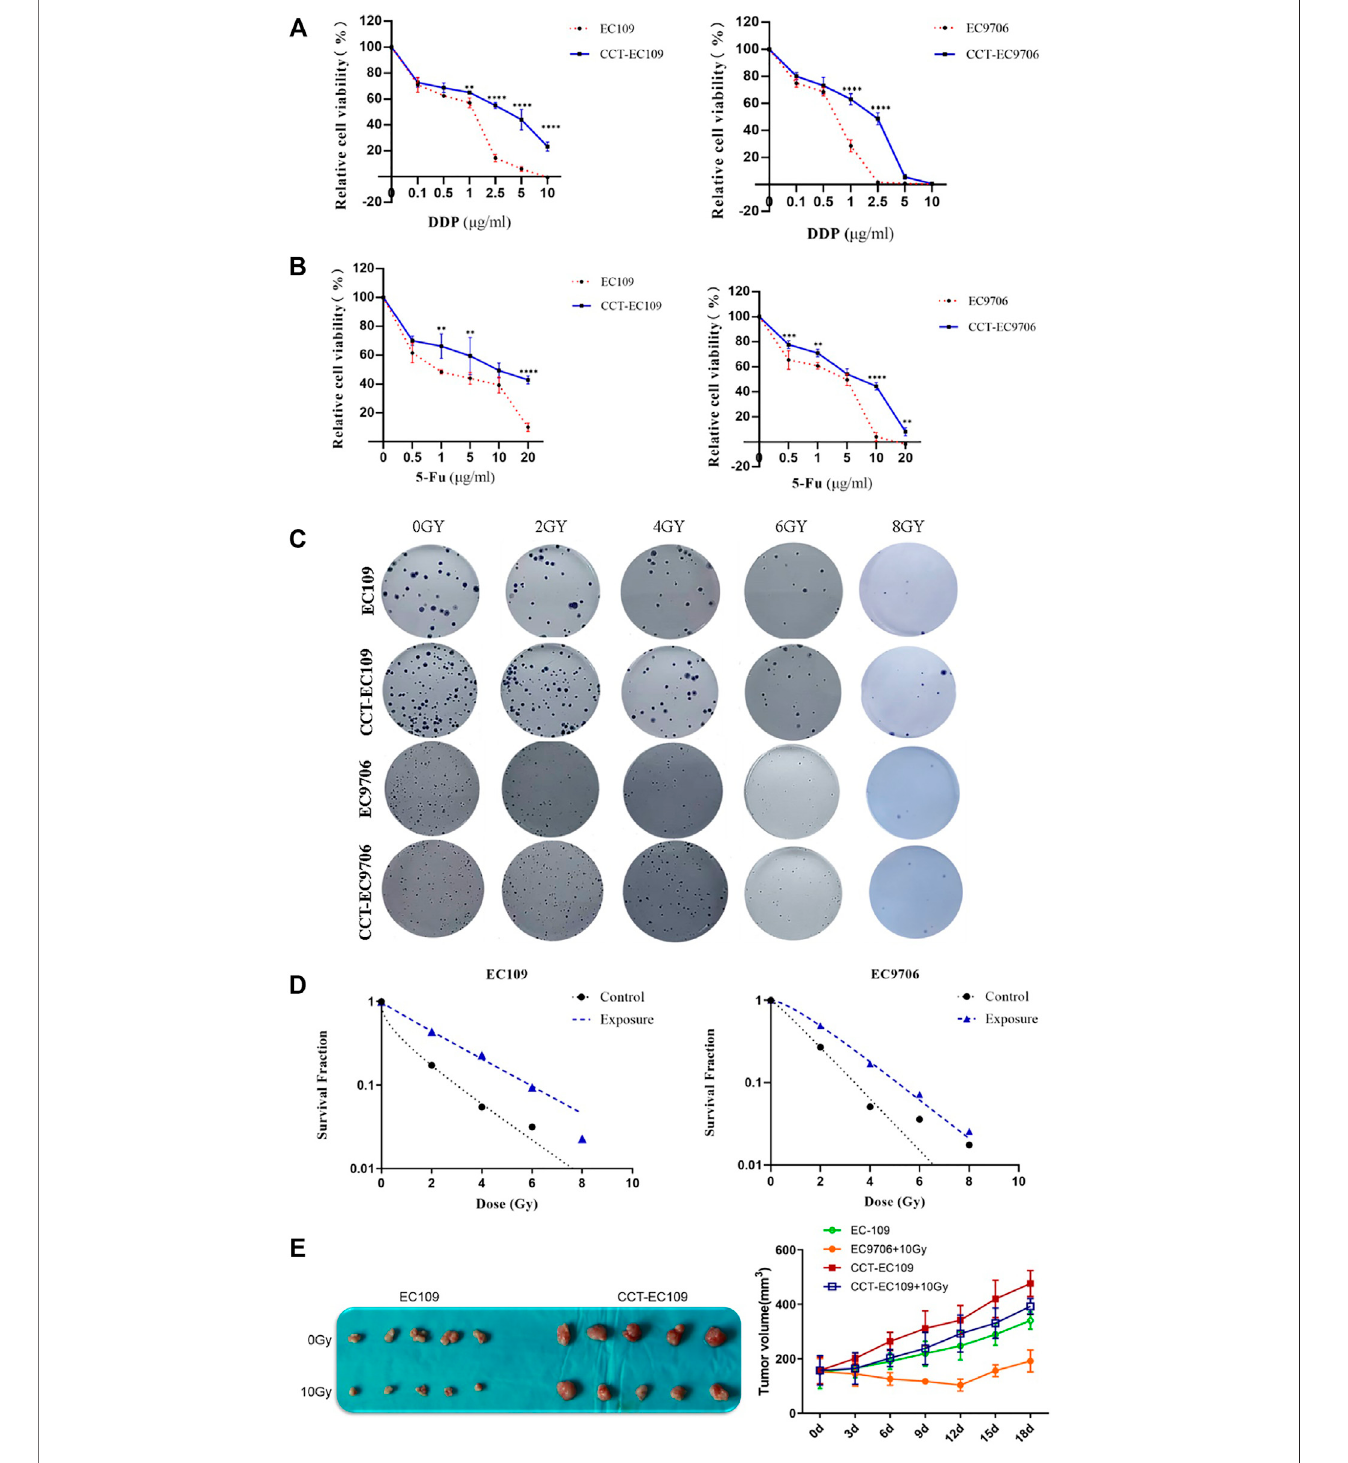
FIGURE4| MTTassay on therelativecellviabilityofCCT-EC109 and CCT-EC9706and their parental cells before and after treatmentwith DDP (A) or5-FU (B) for 48 h. Representative colony formation for different cell groups following irradiation (C) and survival curves for different cell groups following irradiation at different doses were fi tted according to the multi-target single-hit model (D) . Representative photos (left panel of (E) and growth curves (right panel of E) for xenograft tumors following injection with EC109 and CCT-EC109 cells combined with 10Gy irradiation. Data represent mean ± SD of three independent experiments. * p < 0.05; ** p < 0.01; *** p < 0.001.